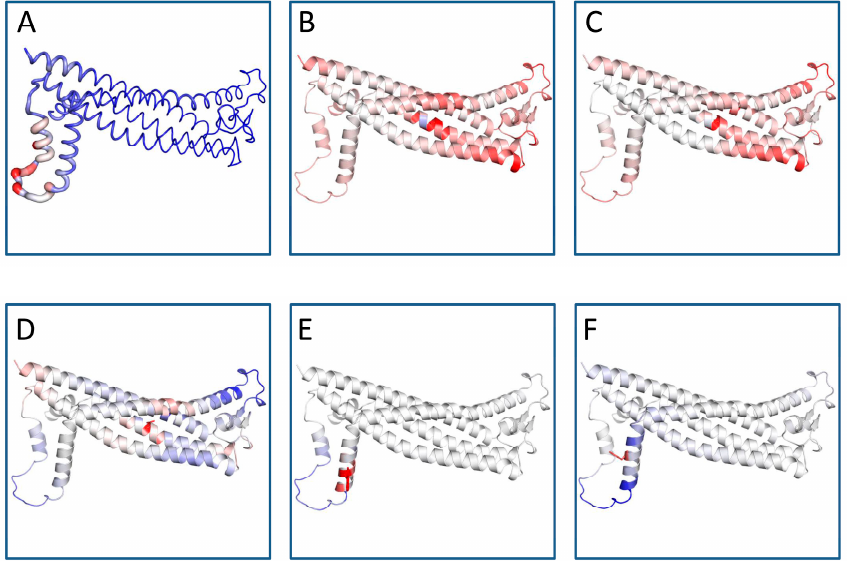
Figure 1. Protein flexible conformation based on the Vibrational Entropy difference ( ΔΔ S) between